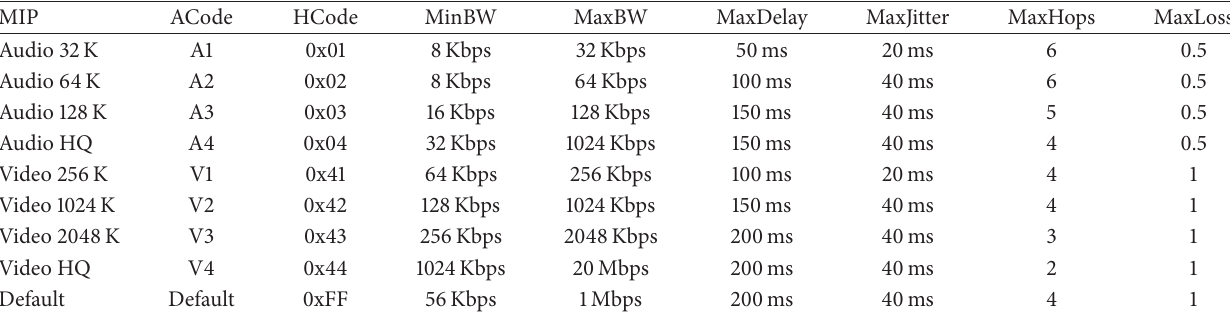
Table 1: Defined MIP list for the practical implementation of the